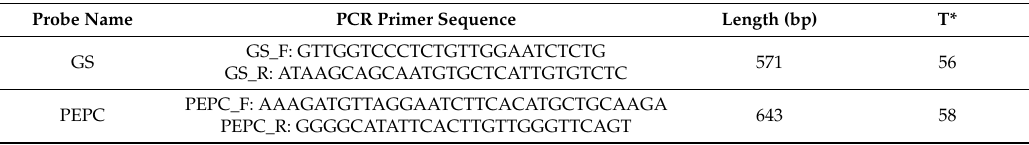
Gene-specific primers used for the probe amplification and verification of positive hybridization